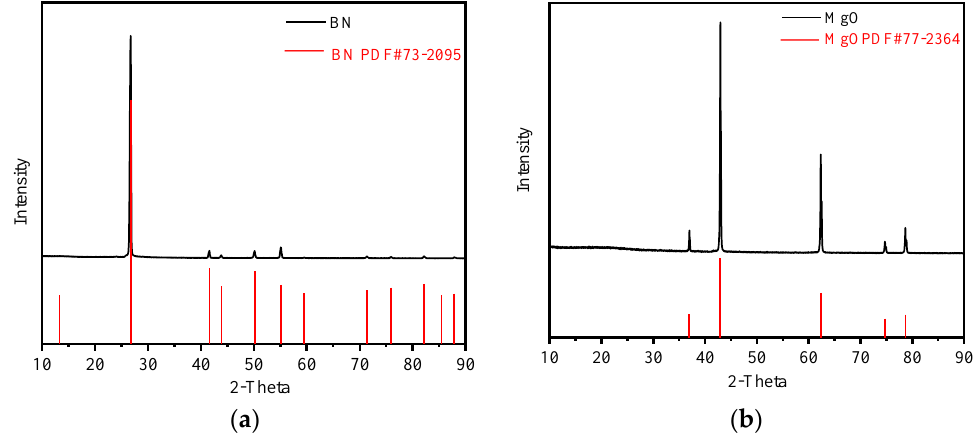
Figure 2. XRD spectrum of BN and MgO powders. ( a ) XRD spectrum of BN; ( b ) XRD spectrum of